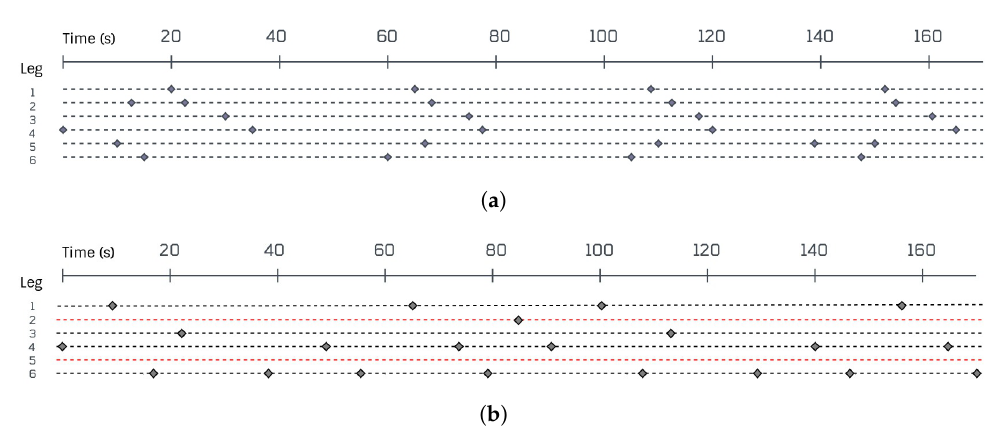
Figure 7. Walking patterns automatically generated for different numbers of legs detected. Each point represents the reallocation of a leg, that is, the turn of a leg to move. For example, in the upper walking pattern, first the fourth leg moves, second the fifth leg, third the second leg, etc. ( a ) Six legs detected. ( b ) Four legs detected. Red lines represent the disabling of a leg.